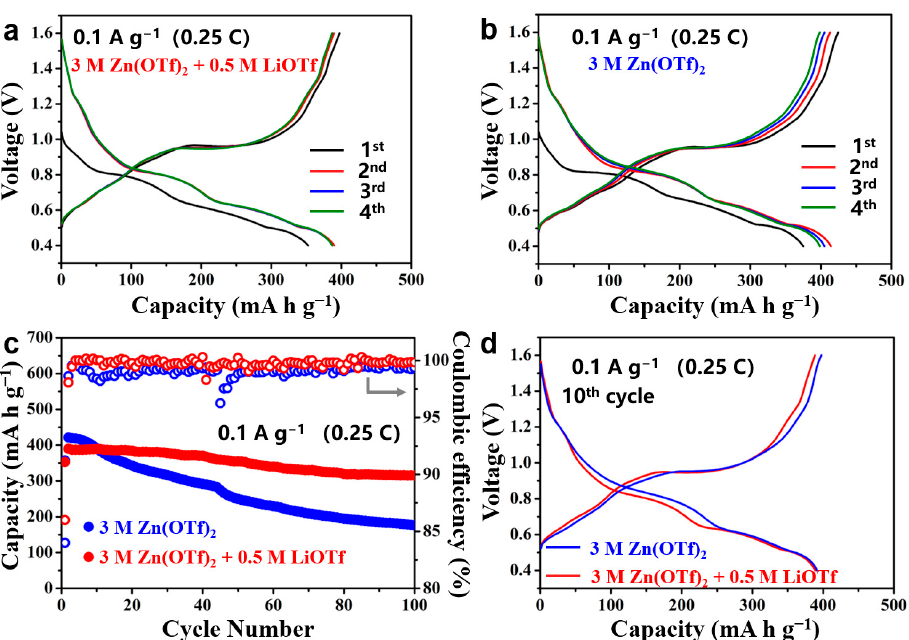
Figure 3. Charge and discharge profiles of the cells using ( a ) 3 M Zn(OTf) 2 + 0.5 M LiOTf electrolyte and ( b ) 3 M Zn(OTf) 2 electrolyte, respectively; ( c ) cycle performances and coulombic efficiencies of the cells at 0.1 A g − 1 (0.25C); ( d ) charge and discharge profiles of the cells at the 10th cycle.